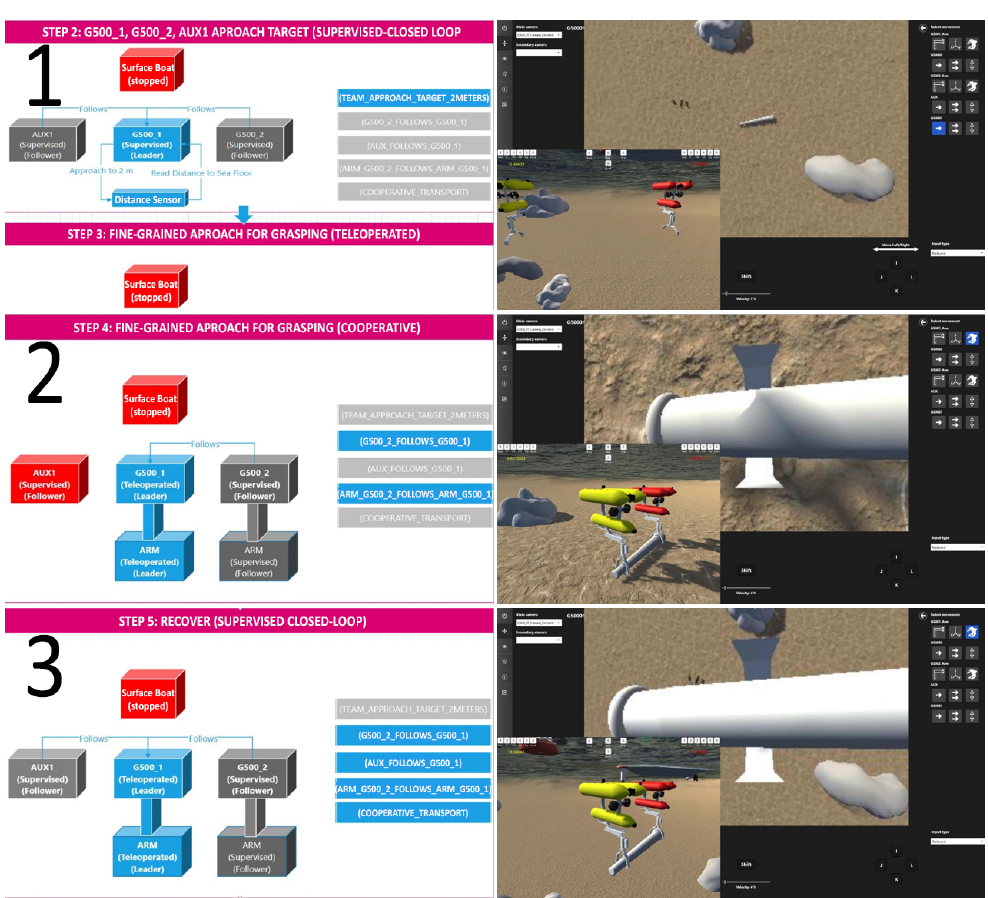
Figure 17. Mission plan sequence: ( 1 ) approaching the pipe, ( 2 ) cooperative grasping, and ( 3 ) cooperative Recovery.